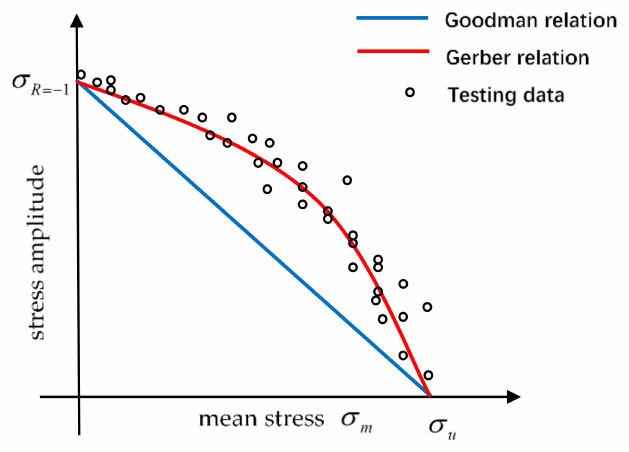
Figure 11. Mean stress effect